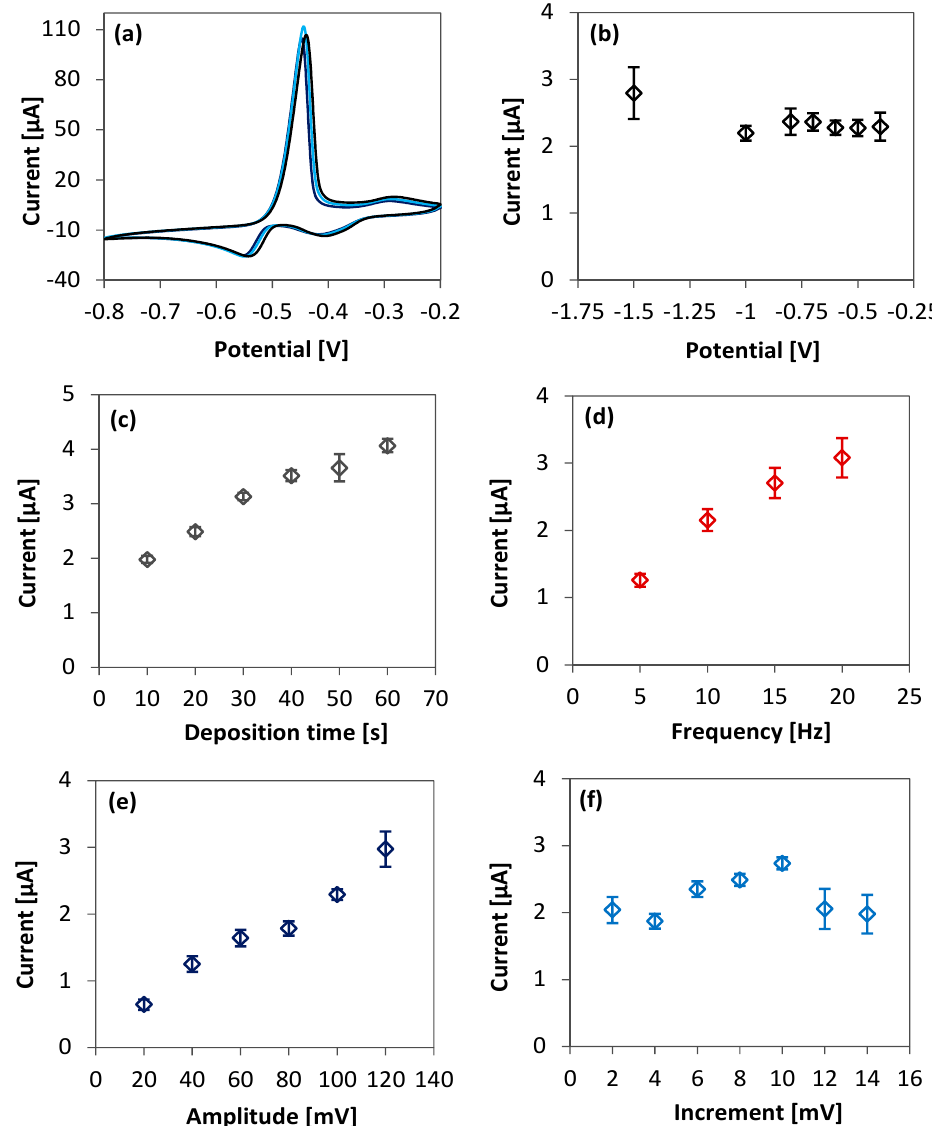
Figure 4. ( a ) CV in 0.2 M, pH 5.2 acetate buffer with 1 mM Pb. Scan rate = 100 mV/s; sweep voltage = − 0.8 V to − 0.2 V. ( b – f ) Optimization of ASV parameters with 10 µM Pb in buffer. Optimized values were − 0.6 V, 10 s, 10 Hz, 100 mV, and 10 mV for deposition potential, deposition time, square-wave frequency, amplitude, and increment step-size, respectively (except for the parameter being varied, other related ASV parameters follow Table 2 during each optimization). Error bars obtained from 10 repeats (n = 10).